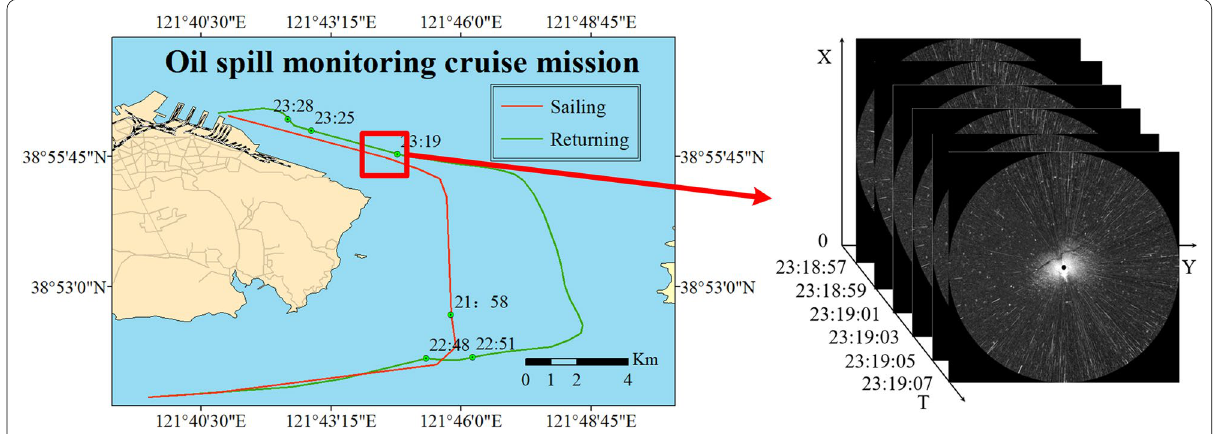
Fig. 1 Oil spill positions observed by the teaching-training ship Yukun on July 21,